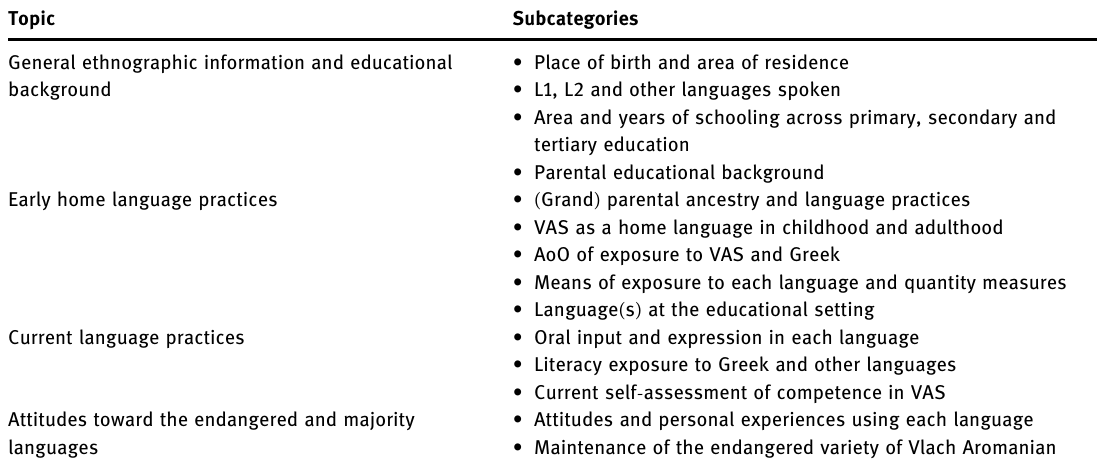
Table 1: Major topics of linguistic pro fi ling questionnaire